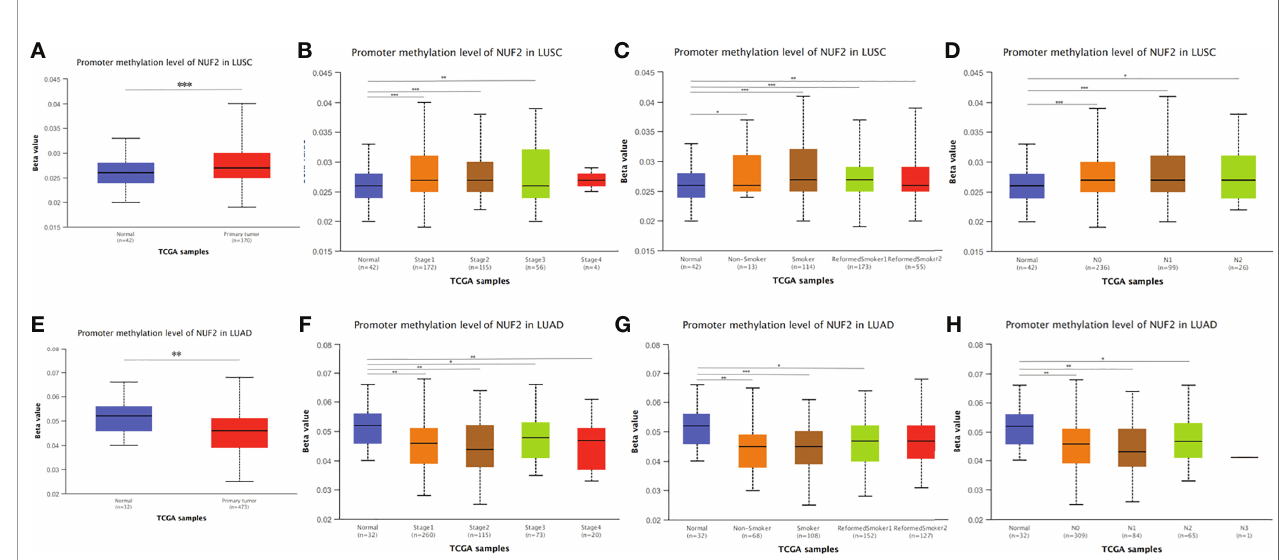
FIGURE 7 | NUF2 DNA methylation status in NSCLC. (A, E) Promoter methylation level of NUF2 of tumor tissues and normal tissues in LUAD and LUSC using TCGA samples via UALCAN. (B – D), (F – H) The association of promoter methylation level of NUF2 with clincopathological factors: stages, smoking habits and N